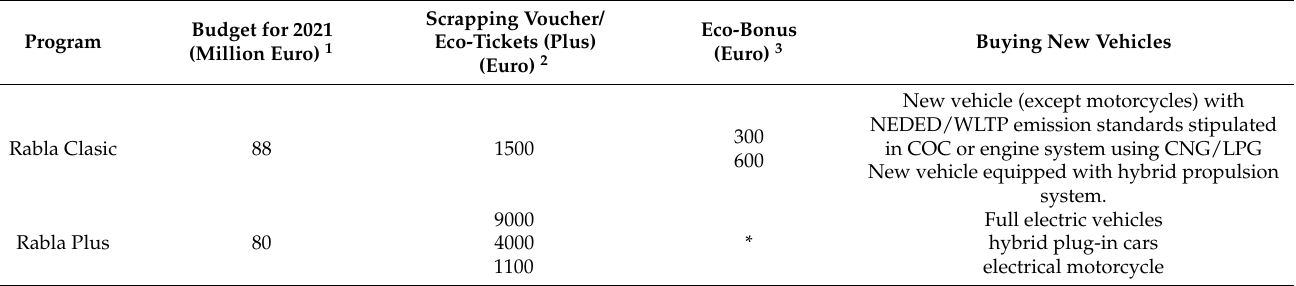
Table 7. Key financial incentives for disposing of ELVs and buying new and low polluting